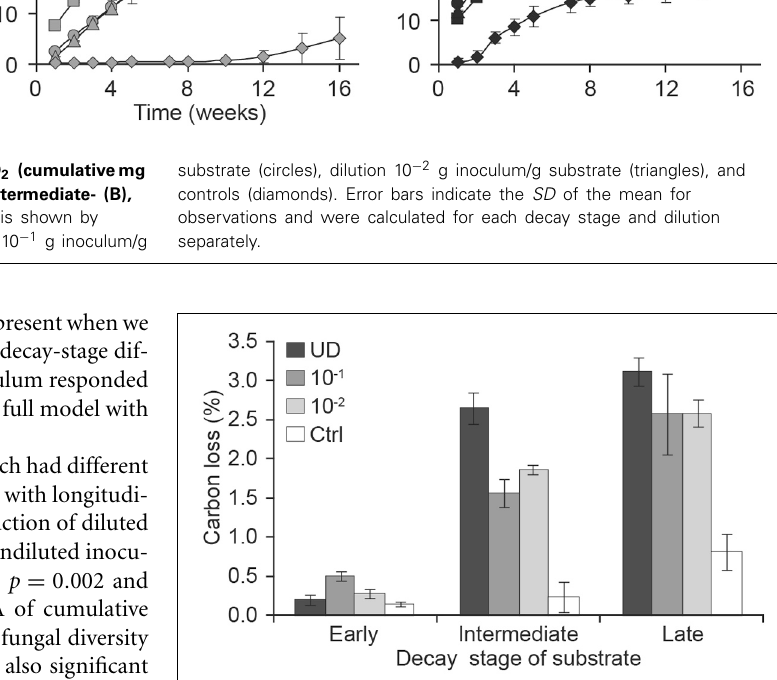
FIGURE 3 | Cumulative carbon loss (means of three replicates) during the incubation of early, intermediate and late stages of decay and receiving various dilutions of fungal inoculum [UD, undiluted; dilution 10 − 1 g inoculum/g substrate (dm); dilution 10 − 2 g inoculum/g substrate (dm); Ctrl, autoclaved